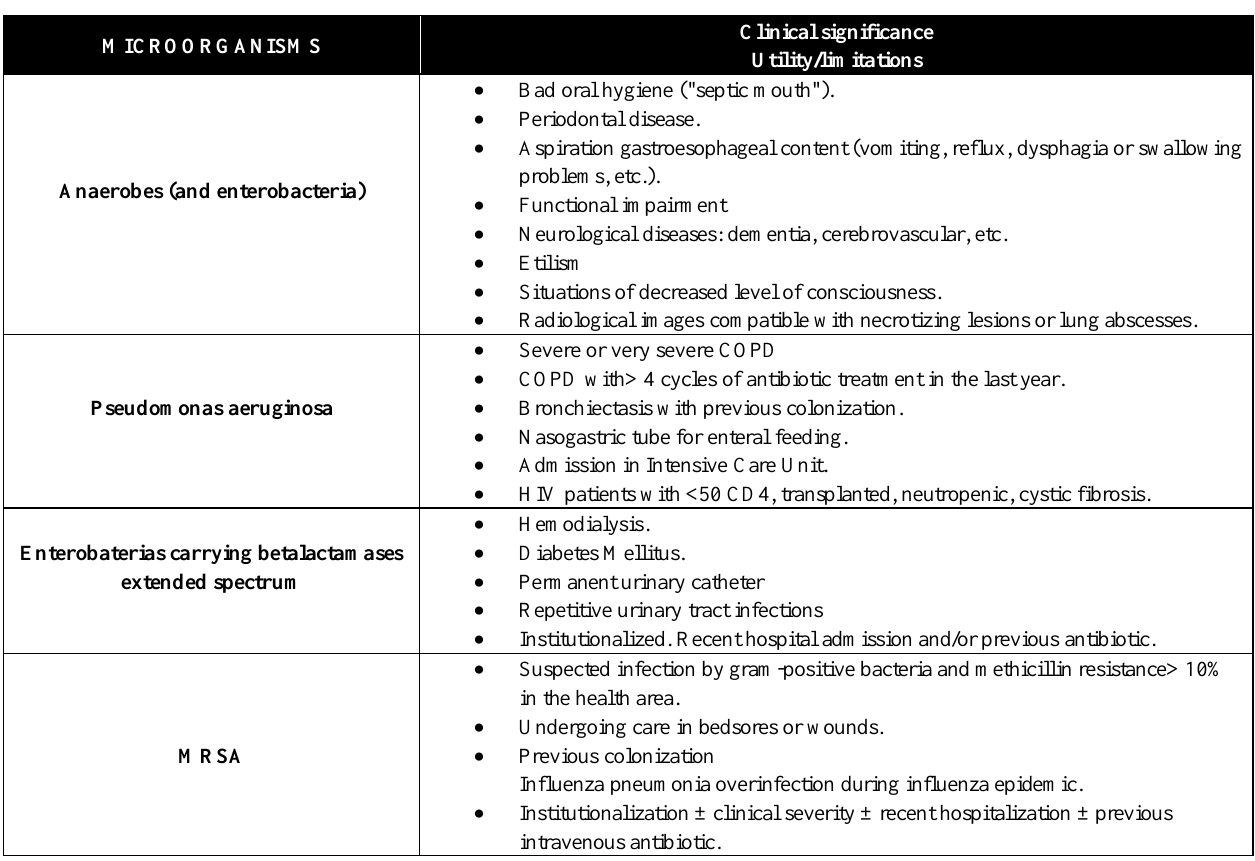
Table 12: Risk factors for less common pathogens of CAP. Cap: Community acquired pneumonia;COPD: Chronic obstructive pulmonary disease; HIV: Human immunodeficiency virus; MRSA: Methicilin resistant S.